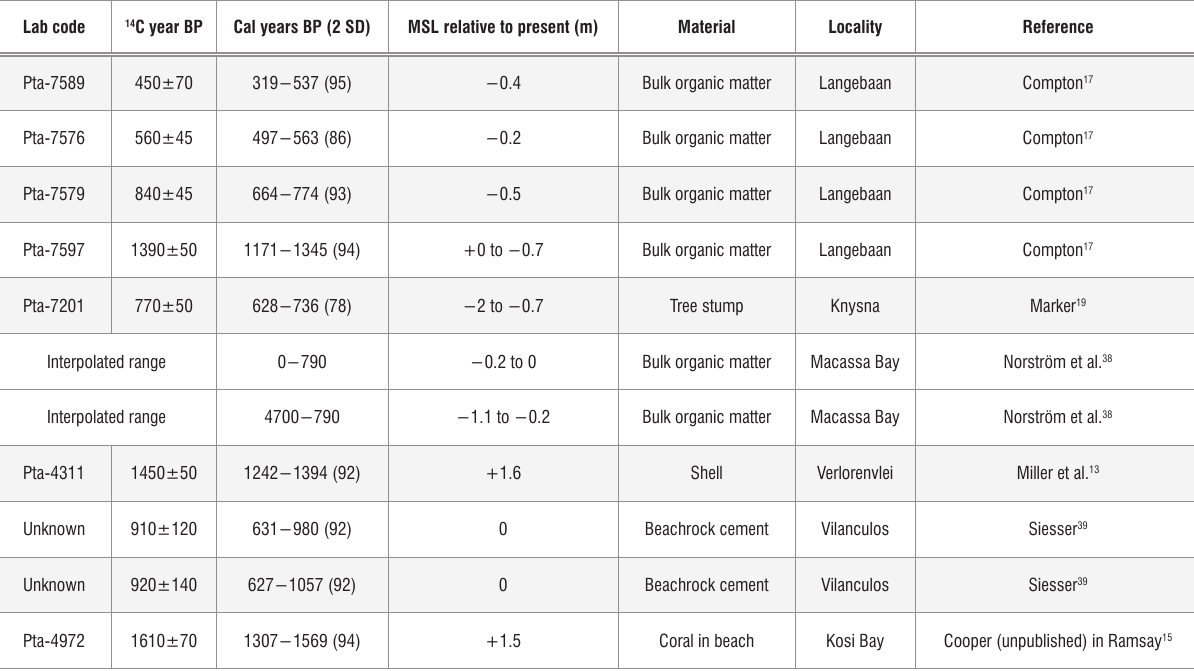
Summary of late Holocene sea-level indicators for southern